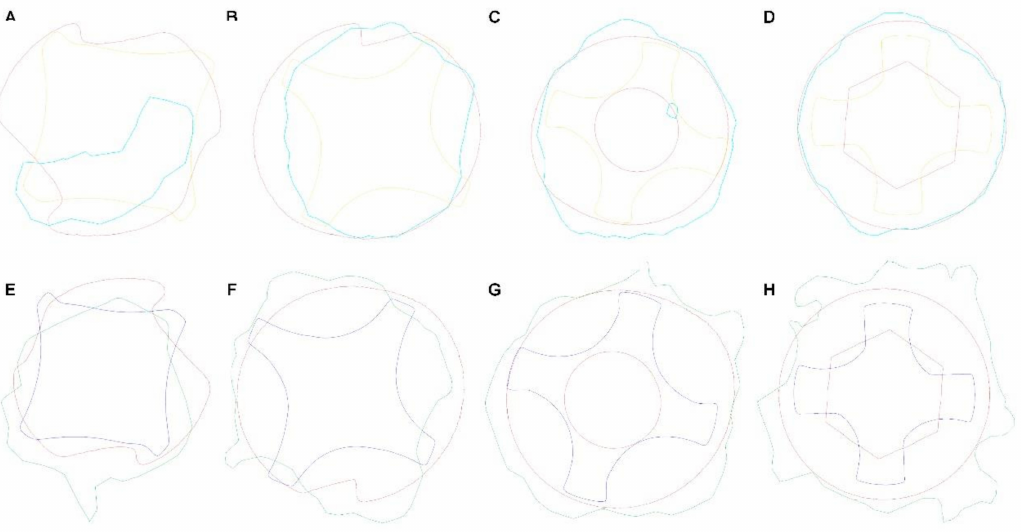
Figure 3. ( A – D ) Cross-sections of the alignment of STL1, STL3, and CBCT 1 and ( E – H ) STL2, STL3, and CBCT 30 at 1, 3, 7, and 11 mm from the 12 mm